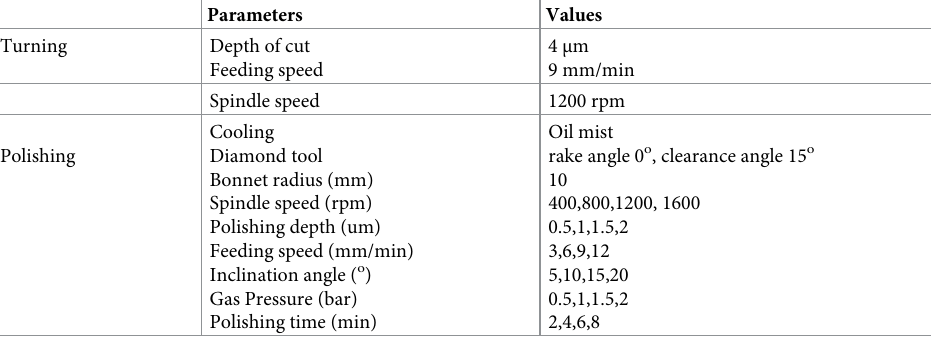
Table 1. Ultra-precision turning and polishing